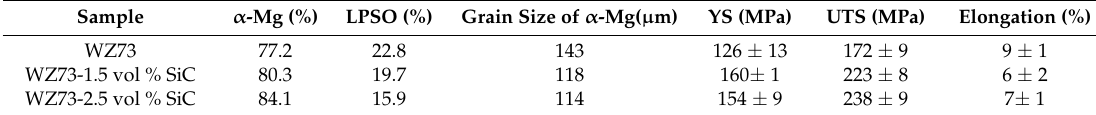
Table 2. Volume fraction of phases, grain size, and tensile properties of the WZ73 alloy and MMCs.